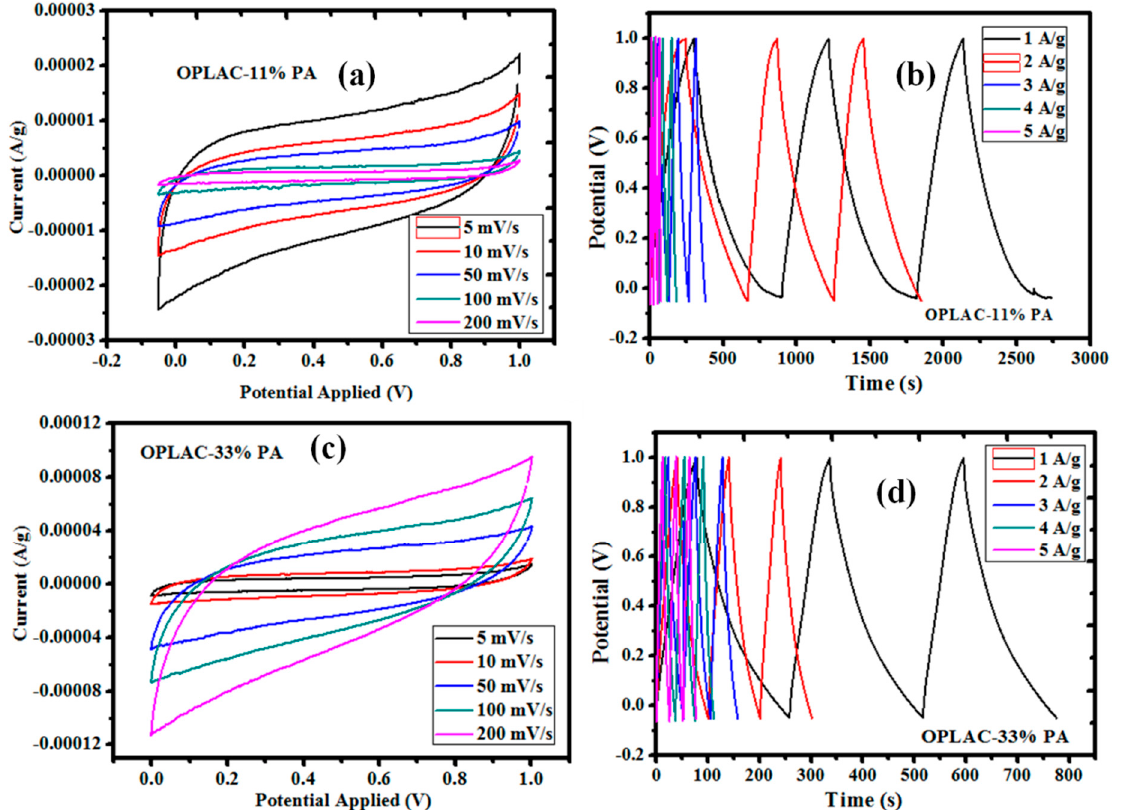
Figure 10. Cyclic voltammogram (CV) and galvanostatic charge and discharge (GCD) curves of the as-fabricated activated carbon obtained from oil palm leaf-derived precursors. ( a ) Represents the CV curves of the OPLAC-11% PA, measured at different scan rates; ( b ) represents the GCD profile of OPLAC-11% PA, measured at different current densities; ( c ) CV curves of the OPLAC-33% PA, measured at different scan rates; ( d ) GCD profile of OPLAC-33% PA, measured at different current densities.